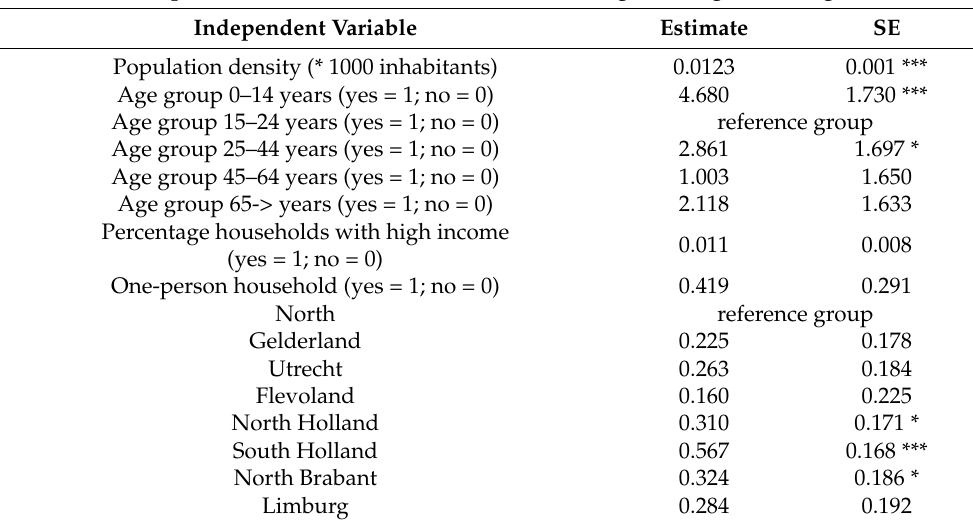
Table 3. Results of mixed regression model with demographic characteristics of neighborhoods as independent variables. Dependent Variable: Ratio of Realized Funding and Target Funding Independent Variable